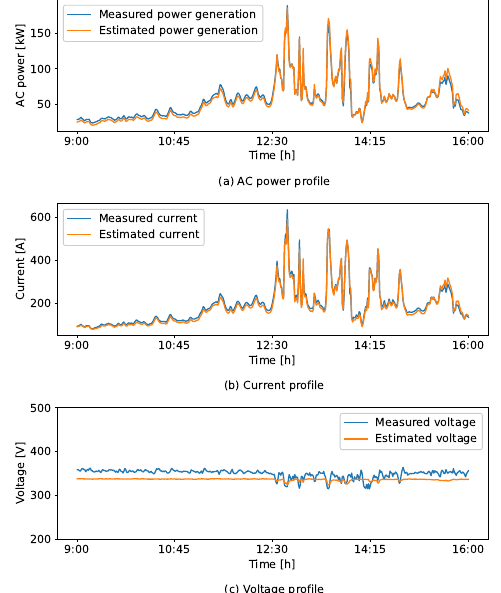
Figure 11. Profile comparison between the estimation and measurement